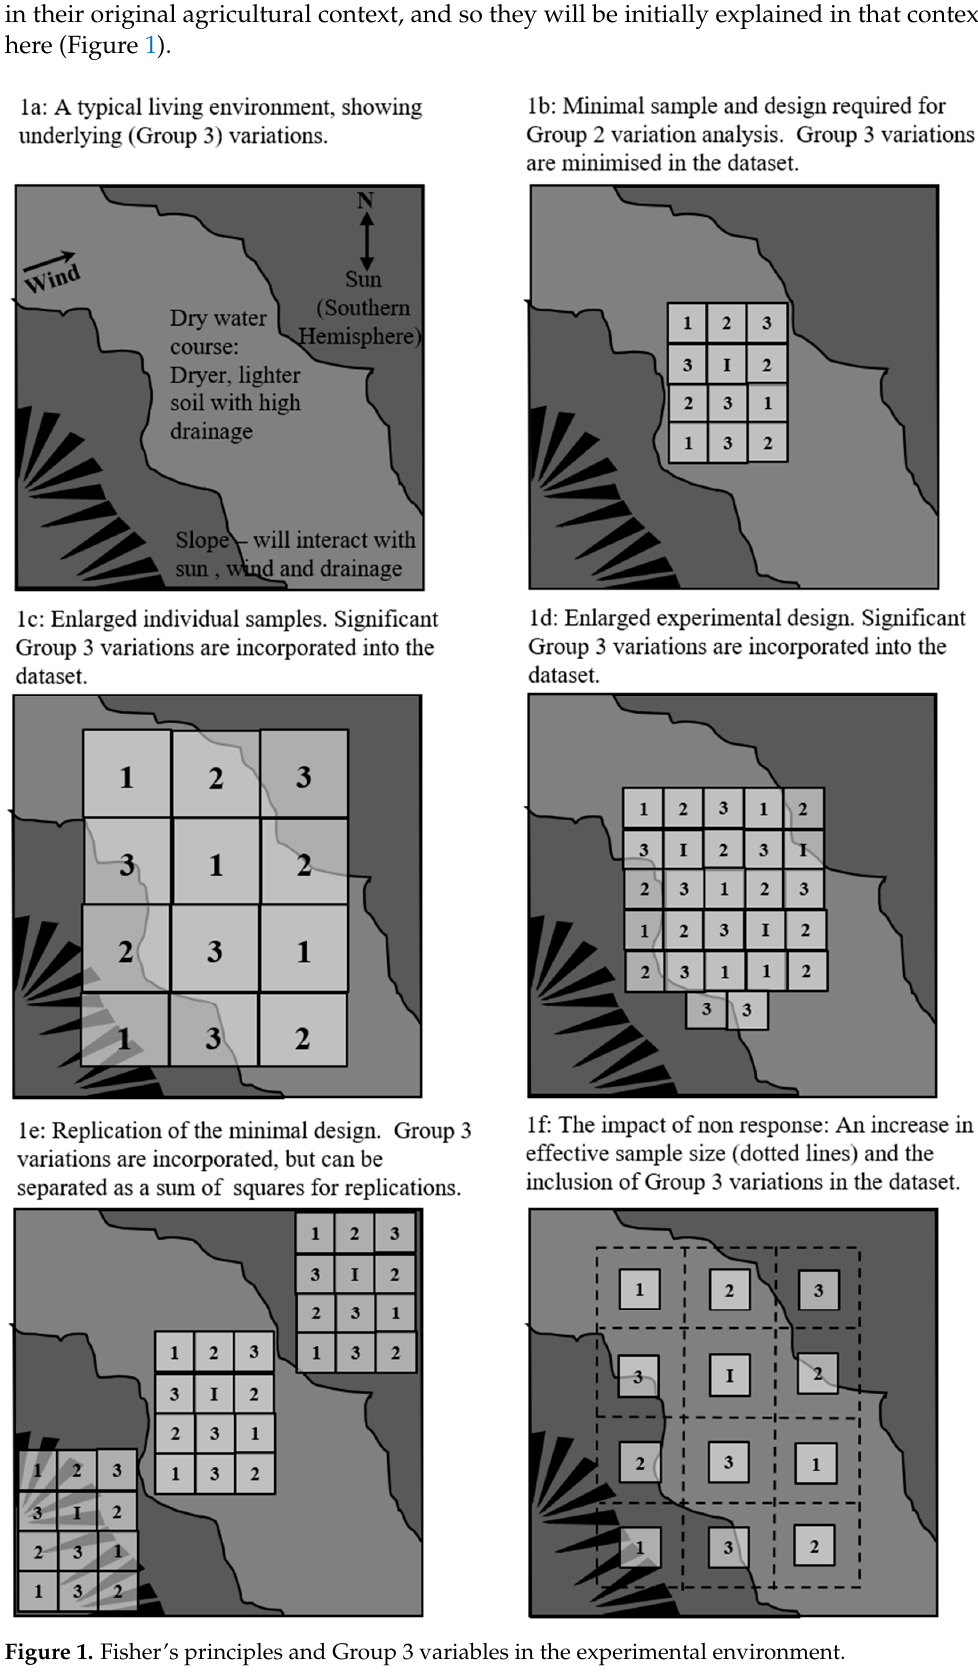
Figure 1. Fisher’s principles and Group 3 variables in the experimental environment.